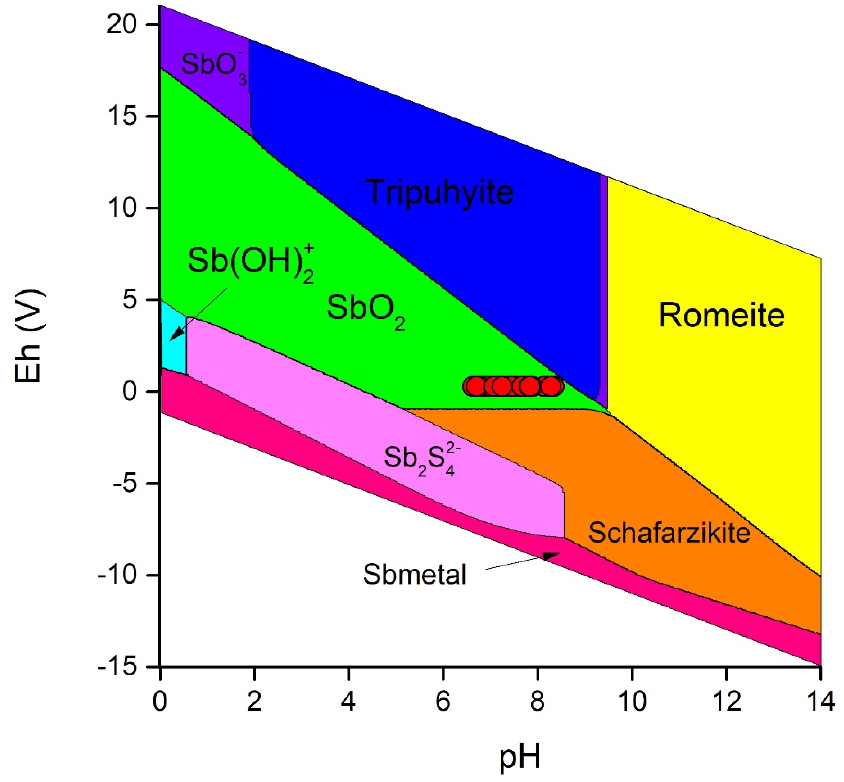
Figure 8. Eh–pH diagrams of Sb–S–Ca–Fe. Red circles represent the CO 2 -saturated eluates.